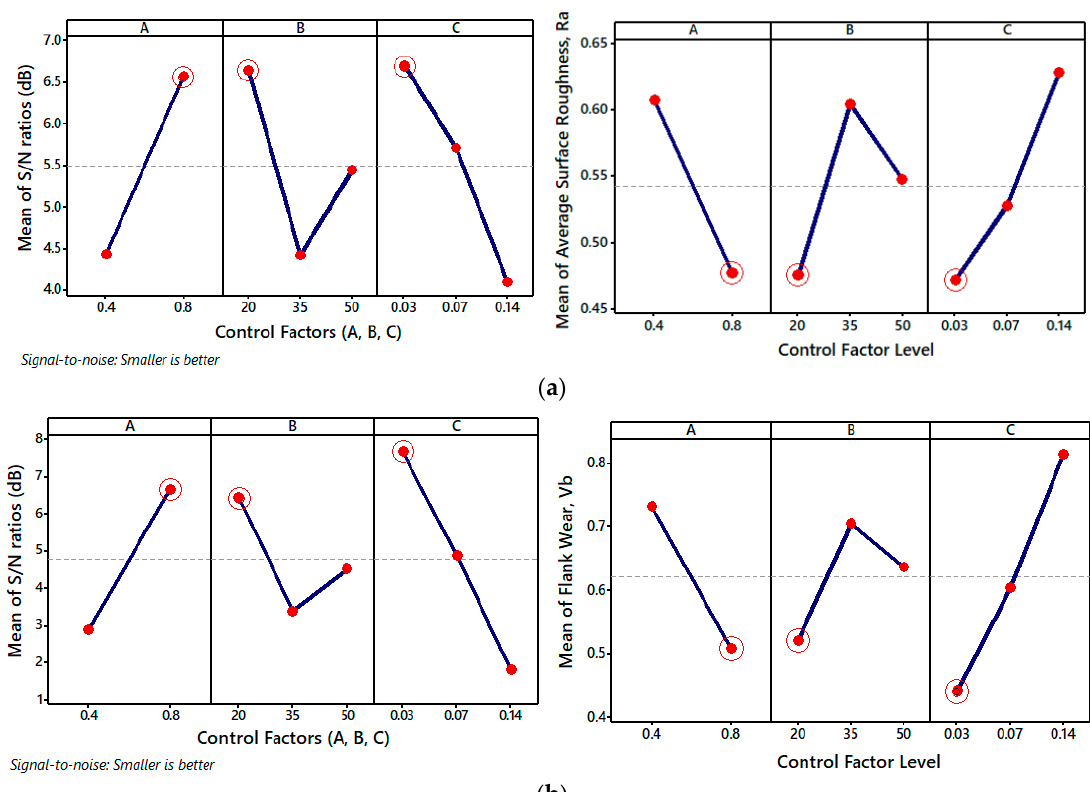
Figure 6. ( a ) Effect of control factors on Ra ( b ) Effect of control factors on Vb. Figure 6. ( a ) E ff ect of control factors on Ra ( b ) E ff ect of control factors on